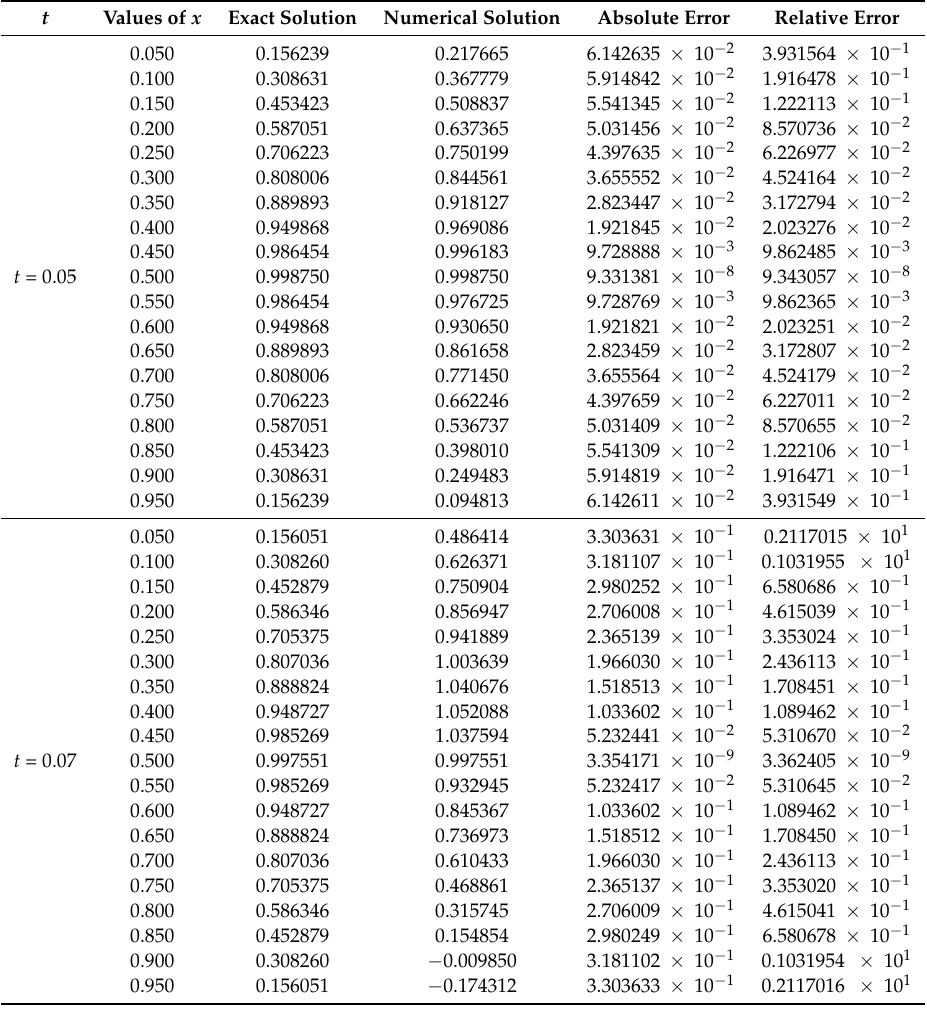
Table 3. Absolute and relative errors at some values of x obtained at times 0.05, 0.07 using 7-terms of HPM (for numerical experiment